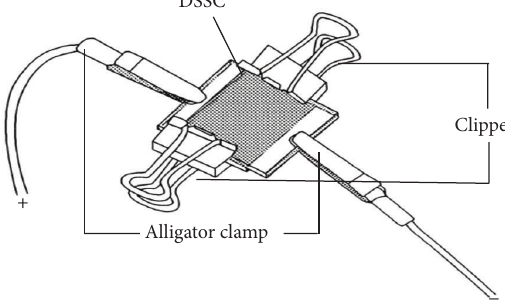
Figure 1: Single cell of assembled dye solar